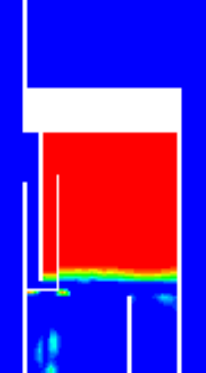
Figure 3. Full air chamber. The red section indicates air, and the blue section indicates water.